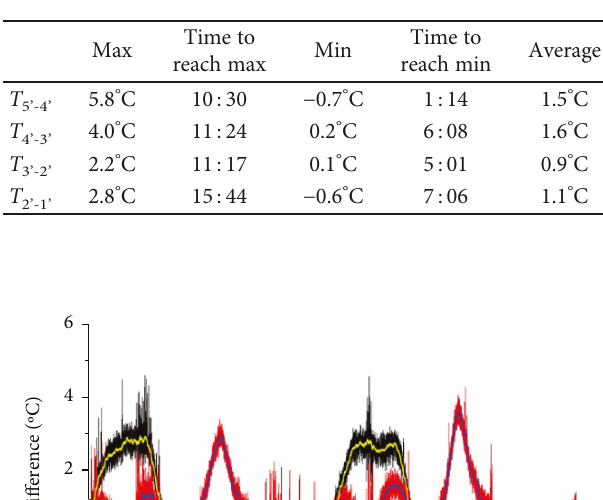
Table 3: Summarized result of temperature di ff erence between nodes of the interior channel.